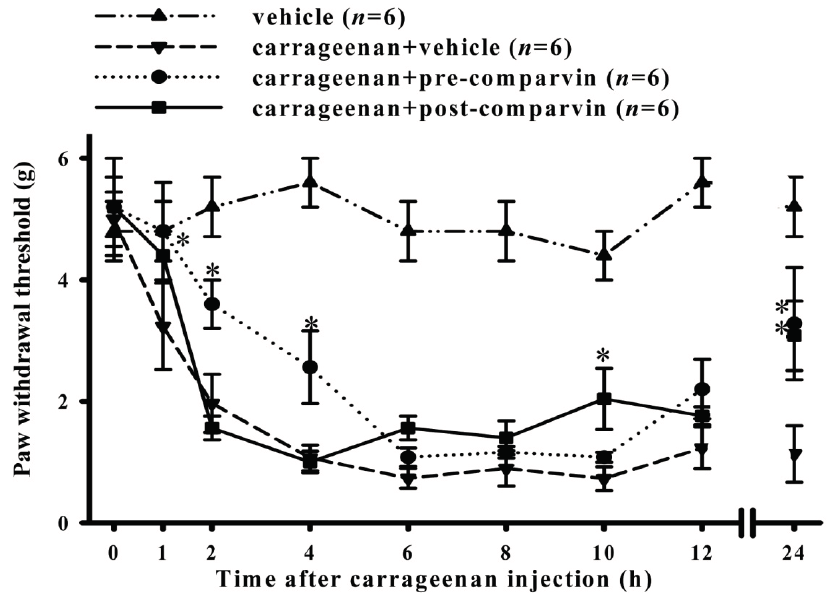
Figure 7. Time course showing the effects of comaparvin on carrageenan-induced mechanical allodynia. The von Frey threshold (g) decreased progressively with a maximum value at 4 to 10 h after carrageenan injection. The pre-treatment comaparvin (30 mg/kg) group showed significantly attenuated carrageenan-induced mechanical allodynia at 1, 2, 4, and 24 h, and the post-treatment group showed significantly attenuated carrageen-induced mechanical allodynia at 10 h and 24 h. Pre-comaparvin, pre-treatment of comaparvin at 1 h before carrageenan injection. Post-comaparvin, comaparvin post-treatment at 4 h after carrageenan injection. Data are the mean ± SEM values. * p < 0.05, significant difference compared with the carrageenan + vehicle